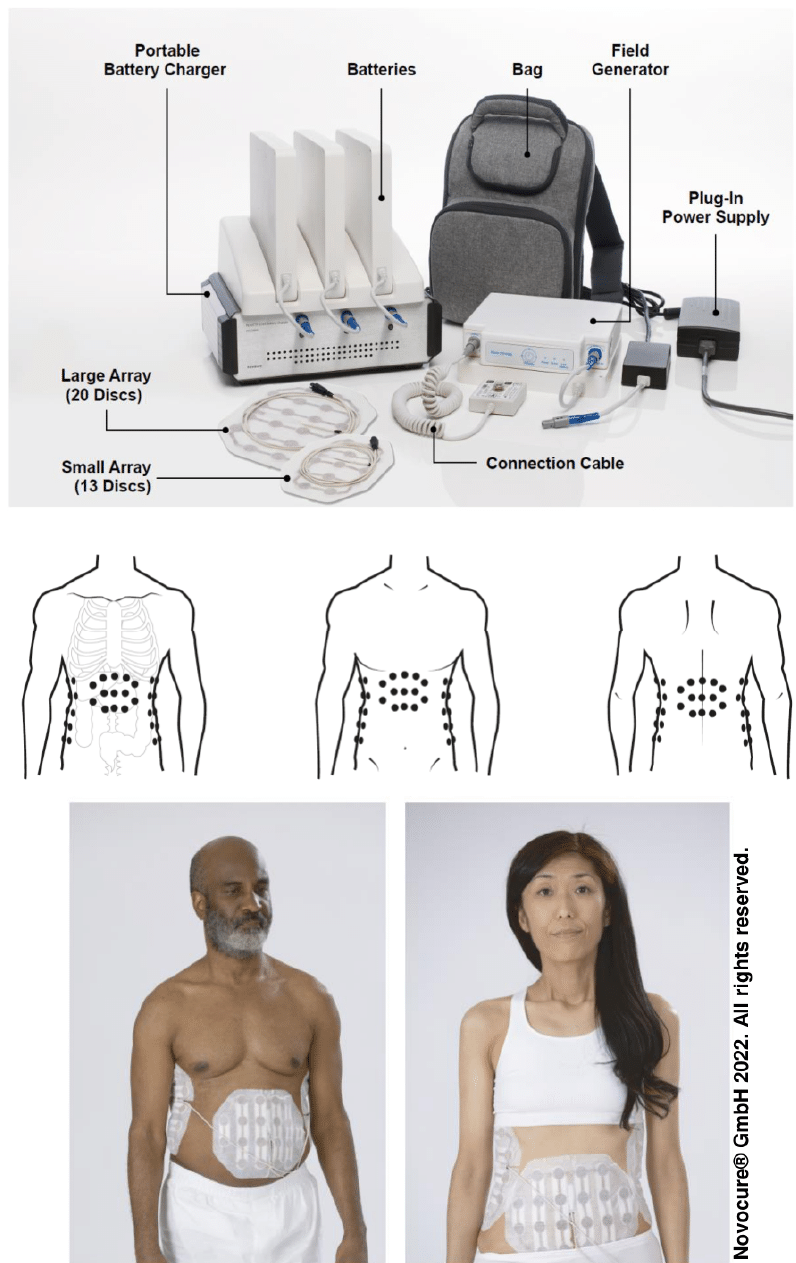
Figure 2. Models shown wearing arrays; models are actors and not patients. Reused with permission from © 2022 Novocure GmbH-all rights